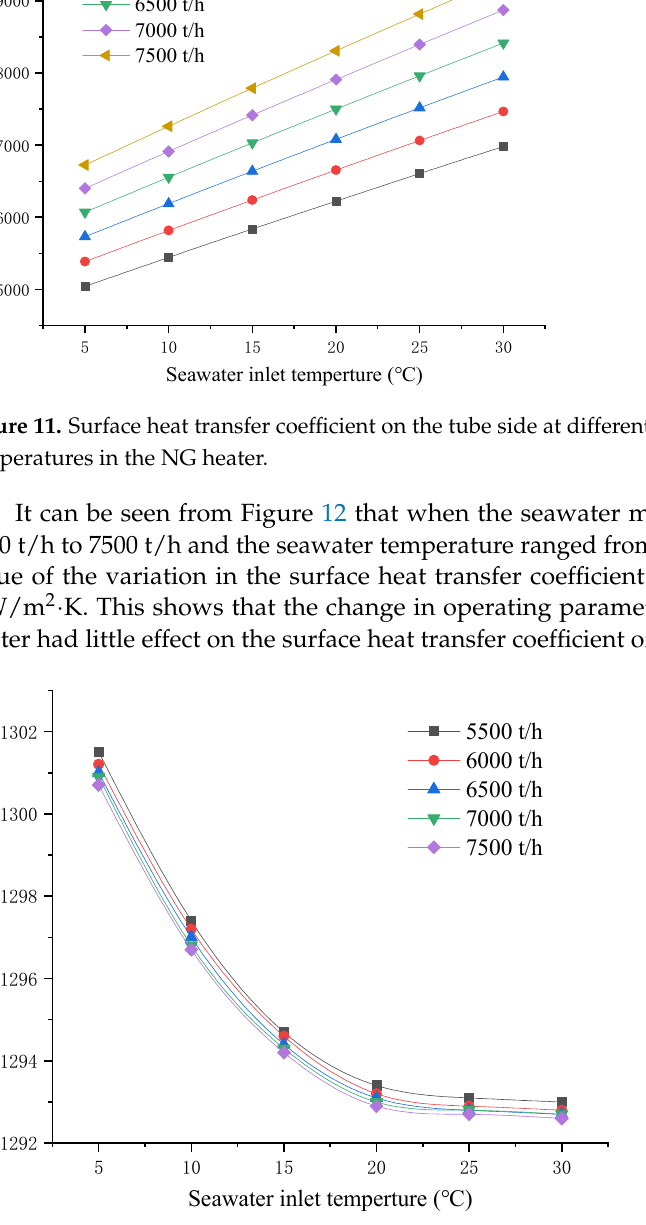
Figure 12. Surface heat transfer coefficients of the shell side at different seawater flow rates and temperatures in the NG heater.